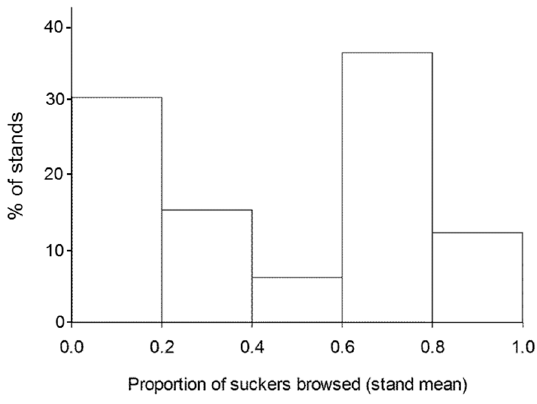
Figure 2. Distribution of proportion of suckers browsed across the stands ( n = 33).